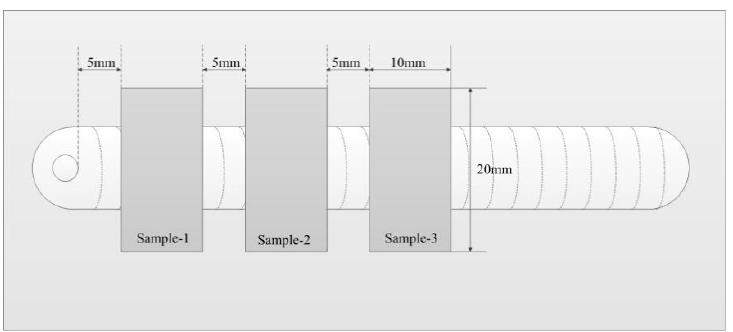
Figure 12. The preparation method of the sample.